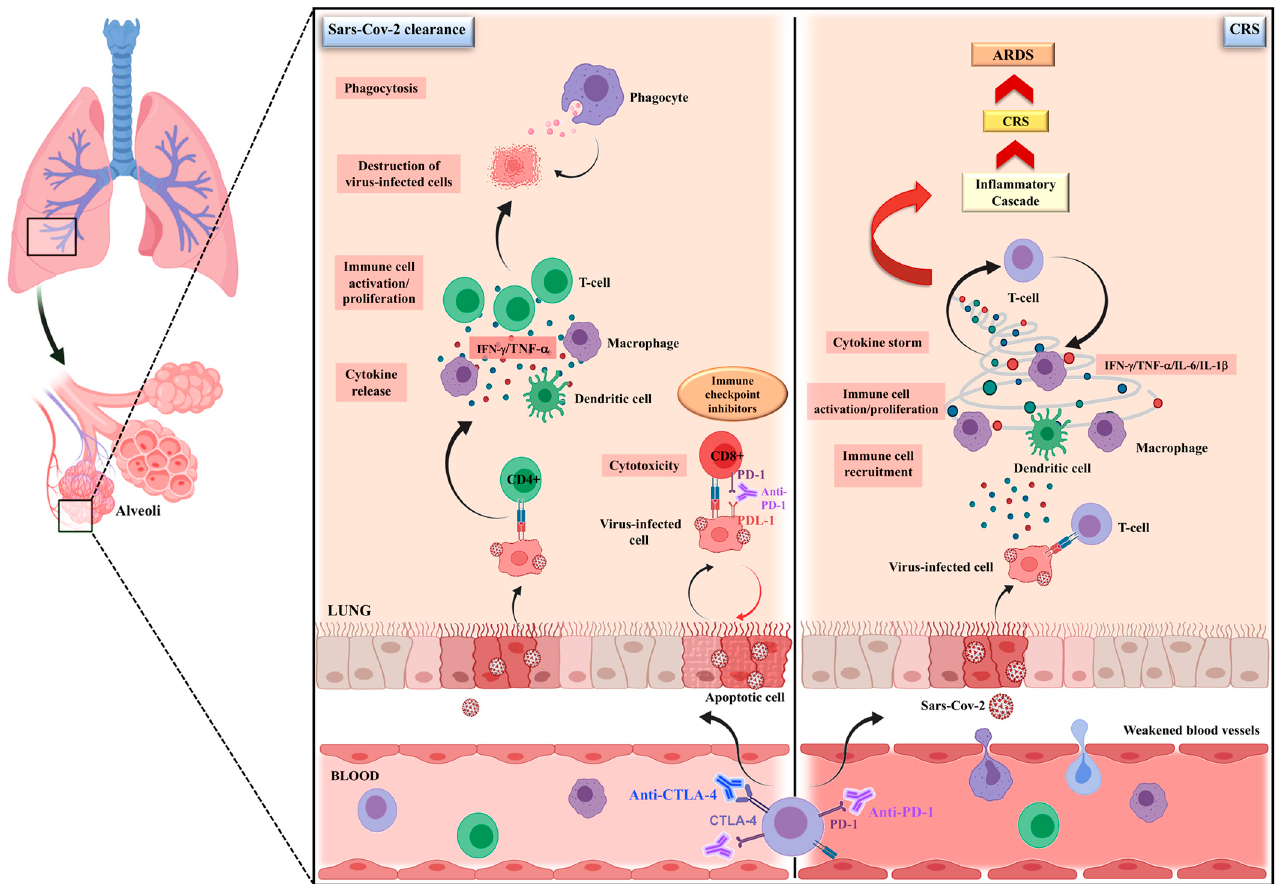
Figure 1. The possible dual impact of immune checkpoint inhibitors on SARS-CoV-2 infection. The debate is still open about the real impact of ICIs on SARS-CoV-2-infected cancer patients. It is well recognized that SARS-CoV-2 infection could negatively influence the host antiviral immune response, contributing to disease severity. On the one hand, by restoring the cellular immunocompetence, ICIs, can enhance the immunological control of infection, accelerating the viral clearance through an increased CD8 + T cell activity, as well as by an improved antigen-dependent recruitment of CD4 T cells, cytokine release and immune-cell proliferation, ultimately leading to the destruction of virus-infected cells by phagocytosis. On the other hand, ICIs may worsen the hyper-inflammatory state that, triggering the cytokine-release syndrome (CRS), leads to lung disruption and, in the worst-case scenario, an acute respiratory distress syndrome (ARDS).